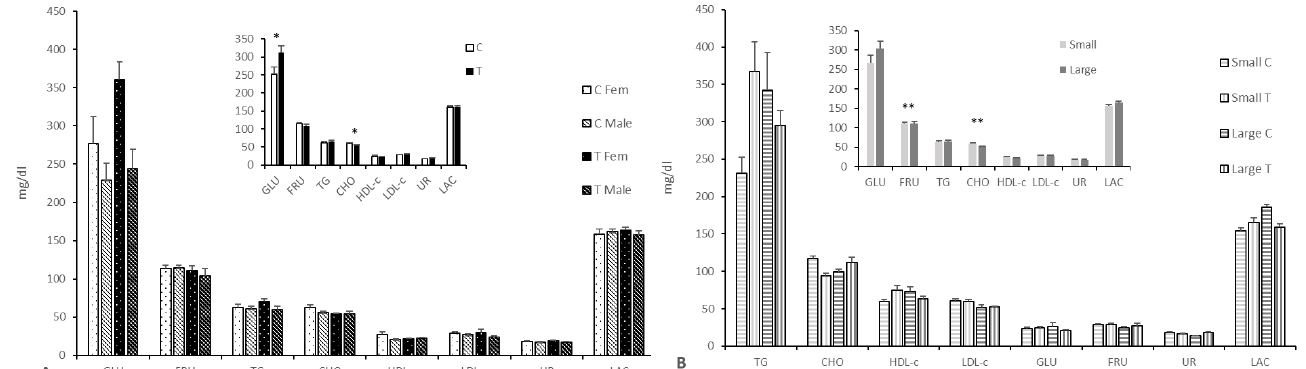
Figure 2. Mean ( ± S.E.M.) plasma concentrations of indexes for glucids ( A ) and lipids metabolism ( B ) at Day 100 of pregnancy in fetuses from control sows (Group C) and sows treated with hydroxytyrosol and n-3-PUFA from Day 35 to Day 100 of gestation (Group T). Main graphs represent sex-and group-differences, while insets represent only group-related differences. TG = triglycerides; CHO = cholesterol; HDL-c = high density lipoprotein cholesterol; LDL = low density lipoprotein cholesterol; GLU = Glucose; FRUC = fructosamine; UR = urea; LAC = lactate. Asterisks denote significant differences (* for p < 0.05 and ** for p < 0.01).